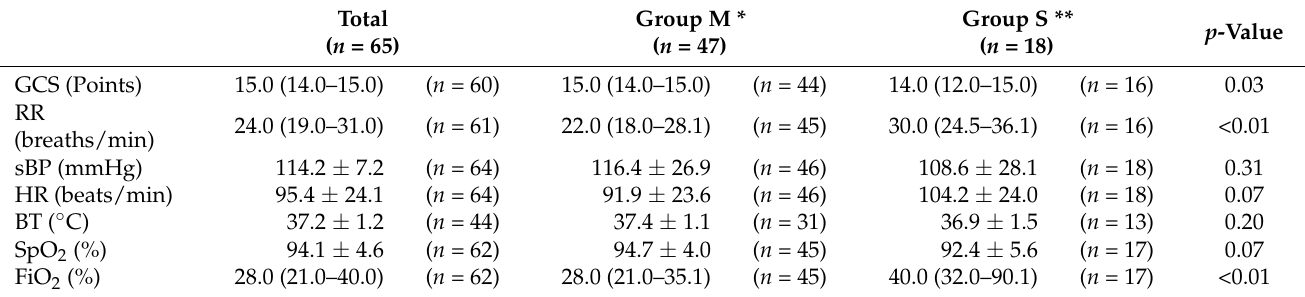
Table 6. Physiological findings at rapid response team (RRT)